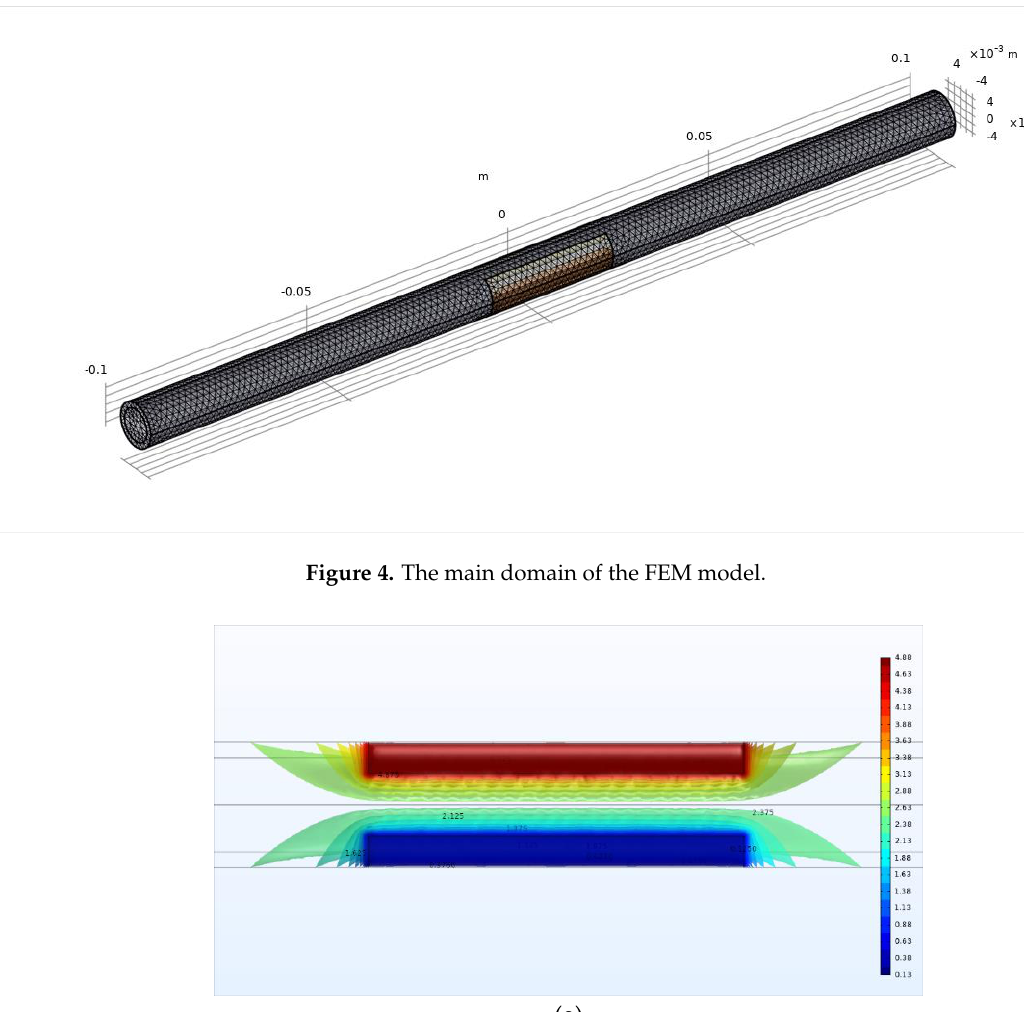
Figure 4. The main domain of the FEM model. Table 1. The properties of the model components.